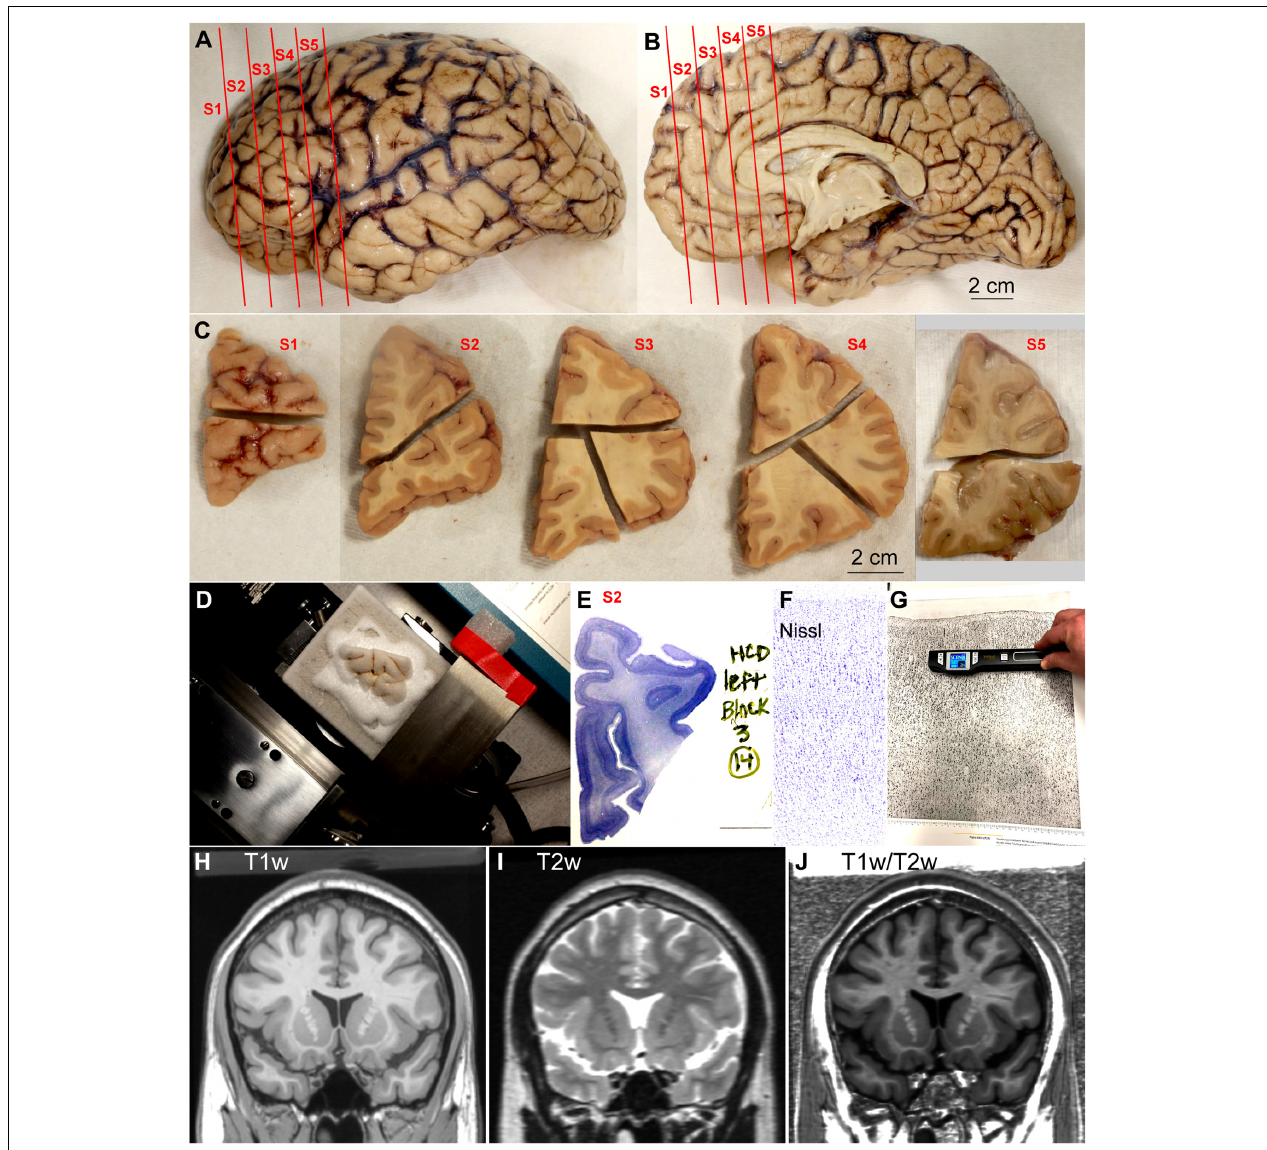
FIGURE 1 | Outline of methods. (A,B) Lateral (A) and medial (B) views of the left hemisphere from the brain (case HCD): red lines show the planes of separation of coronal slabs. (C) , Slabs of the left hemisphere shown in (A,B) cut in smaller blocks; anterior is left and posterior is right. (D) , Dorsal block of S1 (C) frozen on the sliding microtome for cutting into series of sections. (E) , Section of dorsal block of S2 (C) stained for Nissl. (F) , Micrograph of a cortical area through the straight part of the gyrus from a Nissl stained section (original magnification: 10 × ). (G) , Scanning of micrograph from the Atlas of von Economo and Koskinas (1925/2008). (H–J) , Coronal MRI scans of the brain of T1-weighted signal, T2-weighted signal, and the ratio between T1 and T2-weighted signals. S1, S2, S3, S4, S5, indicate coronal slabs from anterior to posterior; T1w, T1-weighted scan; T2w, T2-weighted scan; T1w/T2w, T1/T2 ratio. Calibration bar in (B) applies to (A,B) .